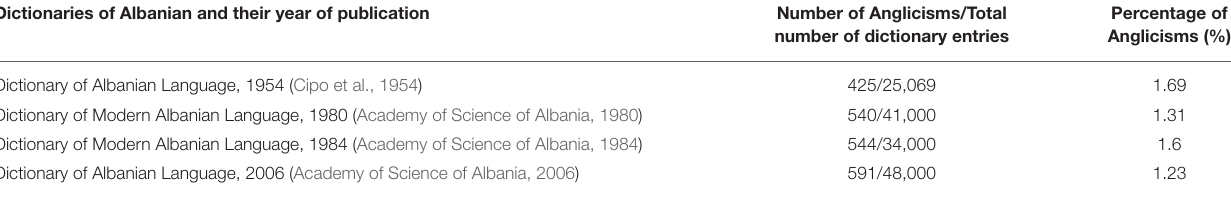
TABLE 1 | Anglicisms in the dictionaries of the Albanian language.